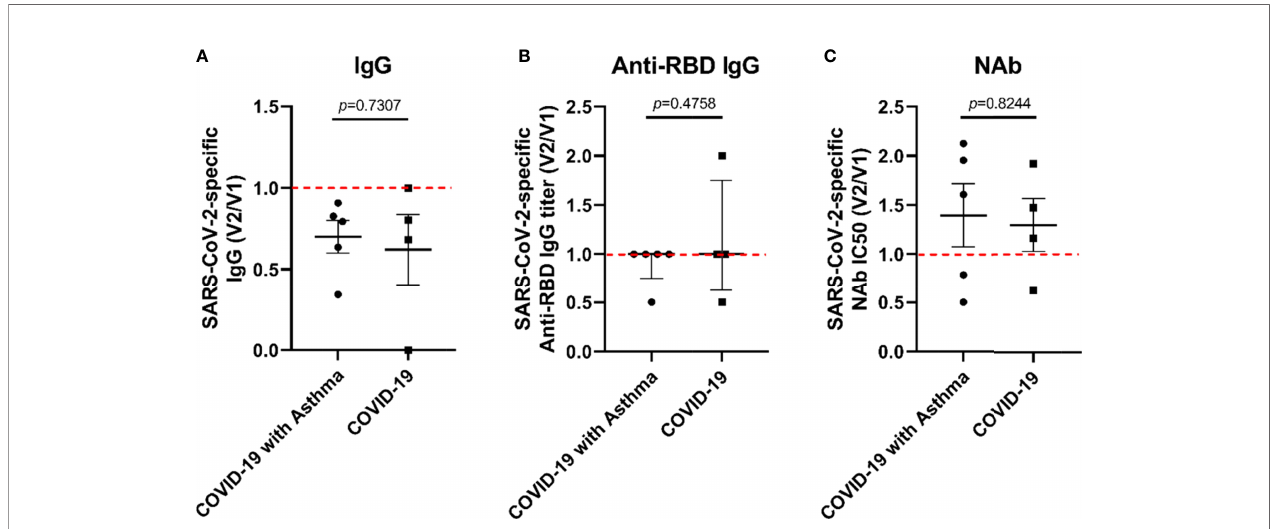
FIGURE 4 | The decay rate of SARS-CoV-2-speci fi c antibodies in COVID-19 survivors with/without asthma. The rate of SARS-CoV-2-speci fi c antibody decay was expressed as the ratio of the antibody value at the second follow-up (V2) to the antibody value at the fi rst follow-up (V1). The decay rate of SARS-CoV-2-speci fi c IgG (A) , anti-RBD IgG titer (B) , and IC50 of NAb (C) were compared between COVID-19 with asthma and COVID-19 subjects. Unpaired t-tests were performed for comparison between two